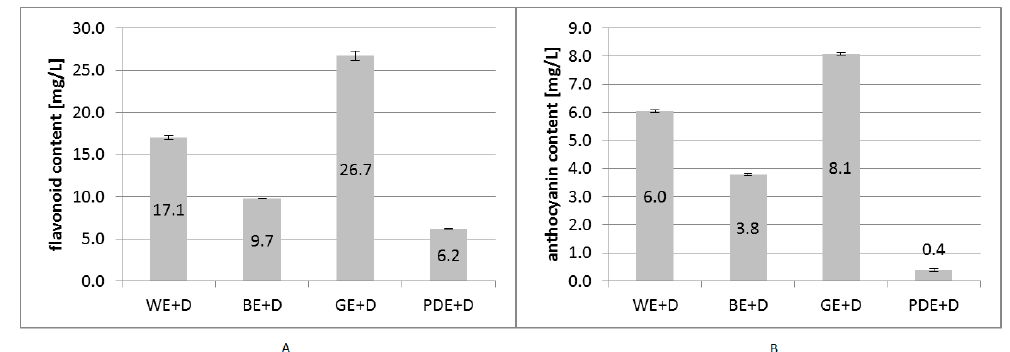
Figure 2. Total content of flavonoids expressed as mg of quercetin equivalents (QU) in 1 L ( A ) and total content of anthocyanins ( B ) in samples of dogwood extracts (WE+D—water extract, BE+D—water/betaine extract, GE+D—water/glycerin extract, PDE+D—water/propanediol extract) averaged from three measurements.